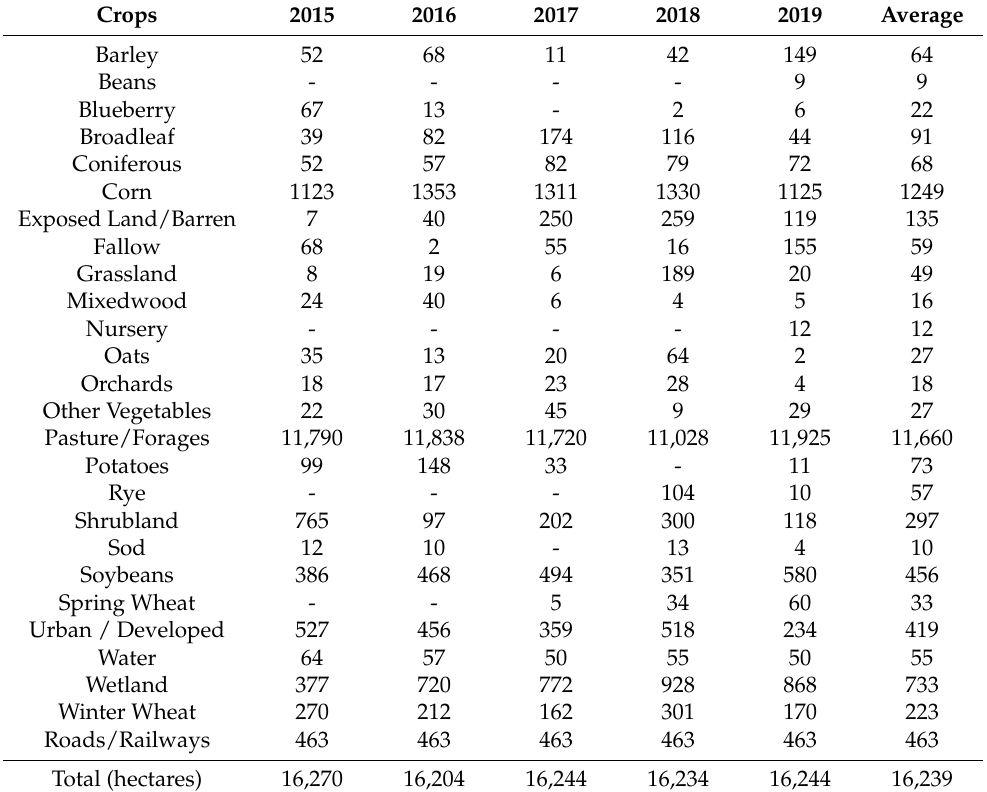
Table 4. Analysis of the Agriculture and Agri-Food Canada’s Annual Crop Inventory from 2015 to 2019.